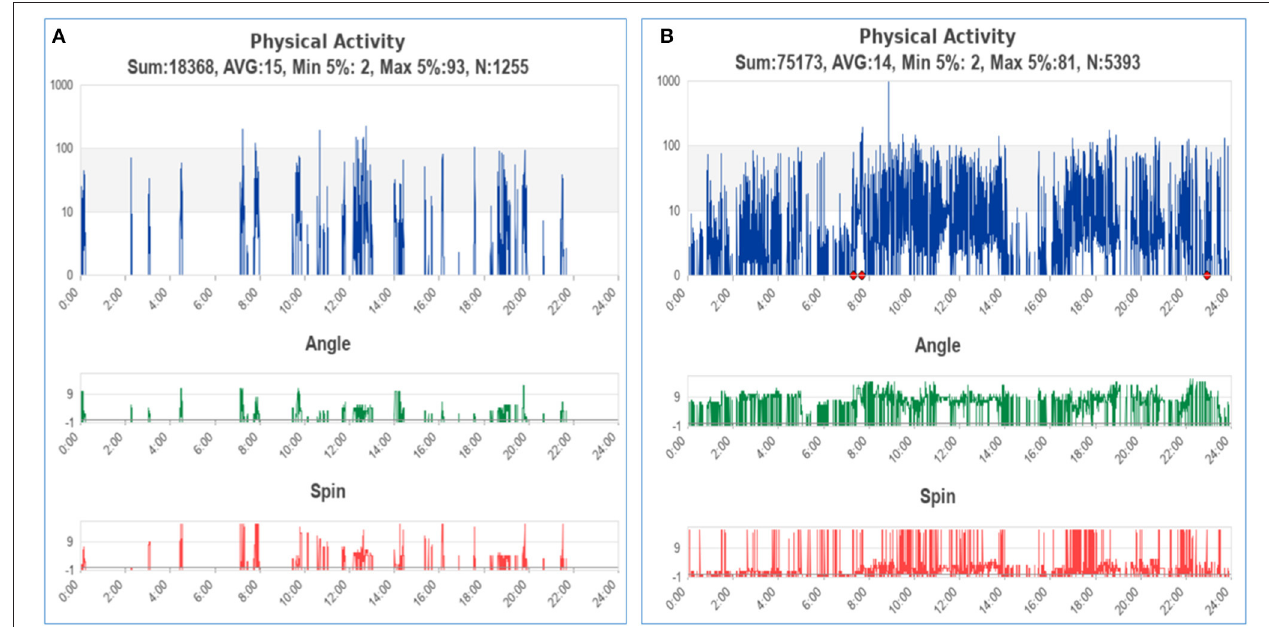
FIGURE 3 | The representative activity pattern of patients with clinical outcomes of death (A) and discharged in stable condition (B) . The red points on the graph indicated that the patient had taken off the device.